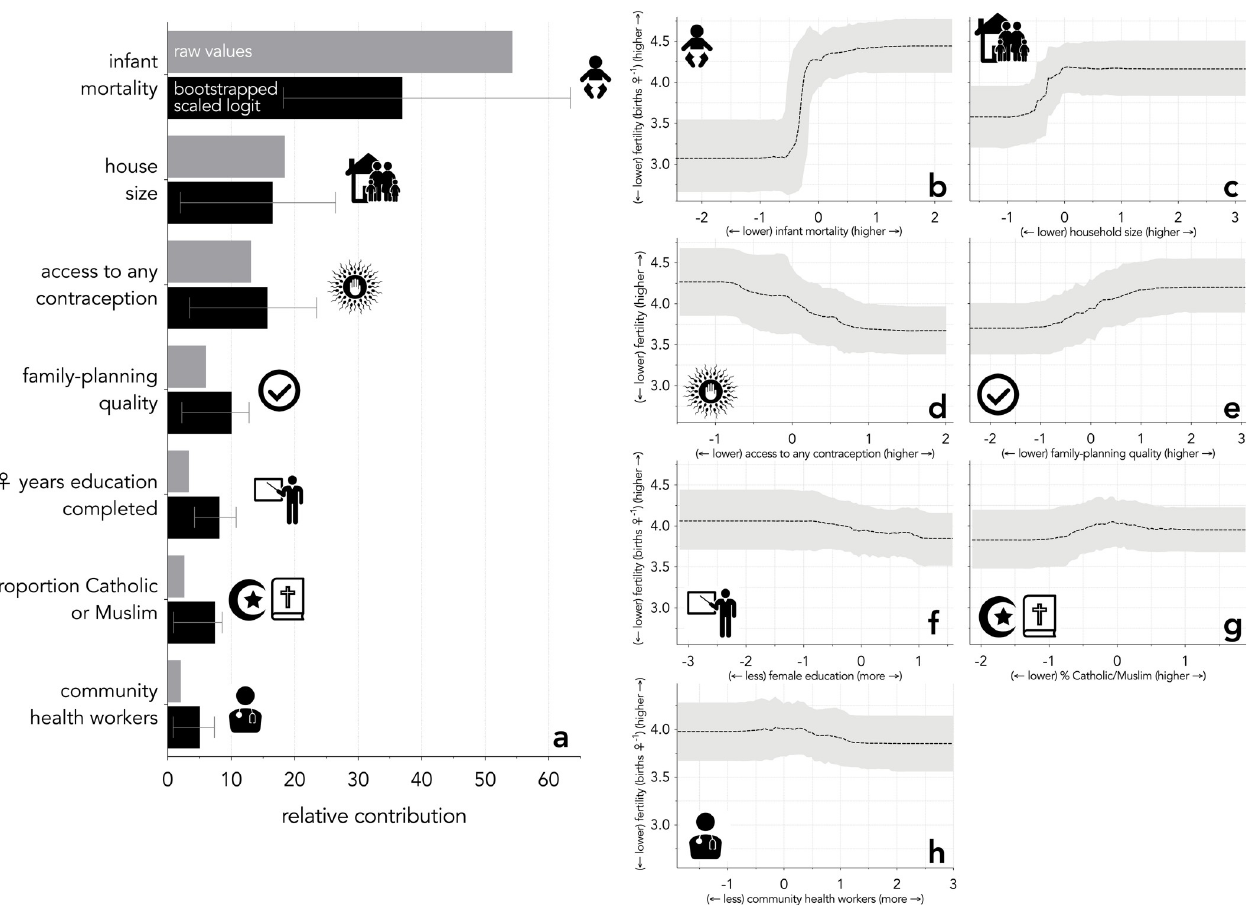
Fig 2. ( a ) The relative contribution and proportion of variance in indicators of family-planning availability, family-planning quality, education, religion, and socio-economics derived from boosted regression trees. The relative contribution of each variable (raw values) to the variance in fertility for each country in the dataset is represented by the grey bars. % deviance explained for raw and bootstrapped boosted regression trees were 77.5% ± 4.6% (25100 trees) and 79.7– 94.9%, respectively. The black bars represent the resampled boosted regression trees for the same variables. Predicted fertility is expressed as a function of variation in ( b ) infant mortality, ( c ) household size, ( d ) access to any form of contraception, ( e ) family-planning quality, ( f ) female education, ( g ) proportion of Catholics or Muslims, and ( h ) visits by a community health worker to discuss family-planning and maternal and child